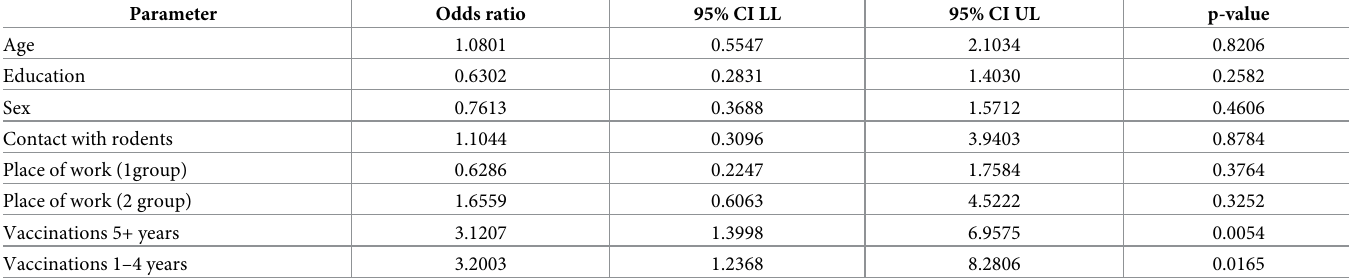
Table 7. Multivariate regression analysis of the relationship between proposed variables and serum antibodies to F1 Y . pestis 12 months after the vaccination.